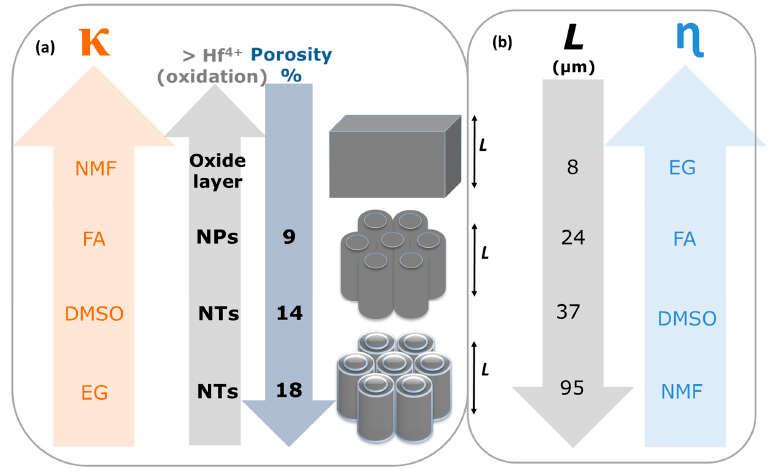
Figure 12. Scheme of ( a) AHO morphology transition from bulk-to-nanoporous (NPs)-to-nanotubes (NTs) with the electrolyte solvent constant dielectric constant ( κ ) increase (as the porosity ( P ) decreases); and ( b ) the AHO layer thickness ( L ) increase with the viscosity ( η ) decrease.